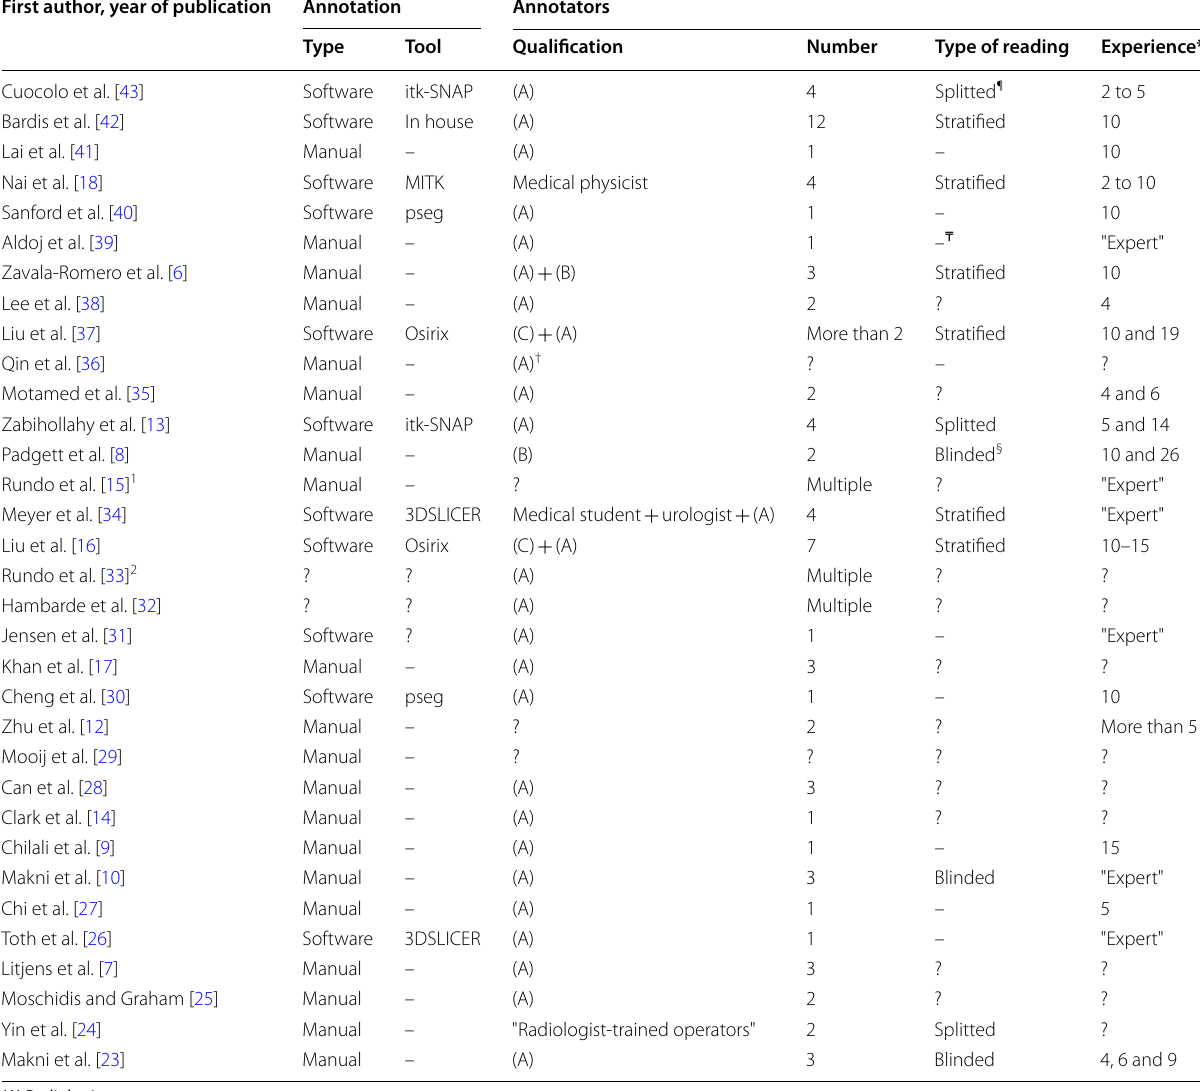
Table 4 Type of ground truth